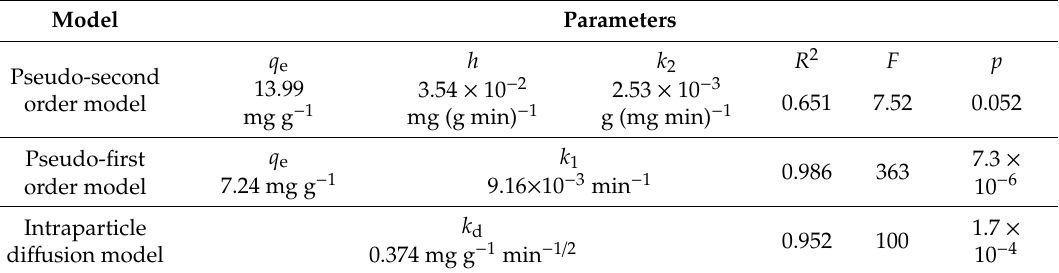
Table 5. Kinetic model parameters.